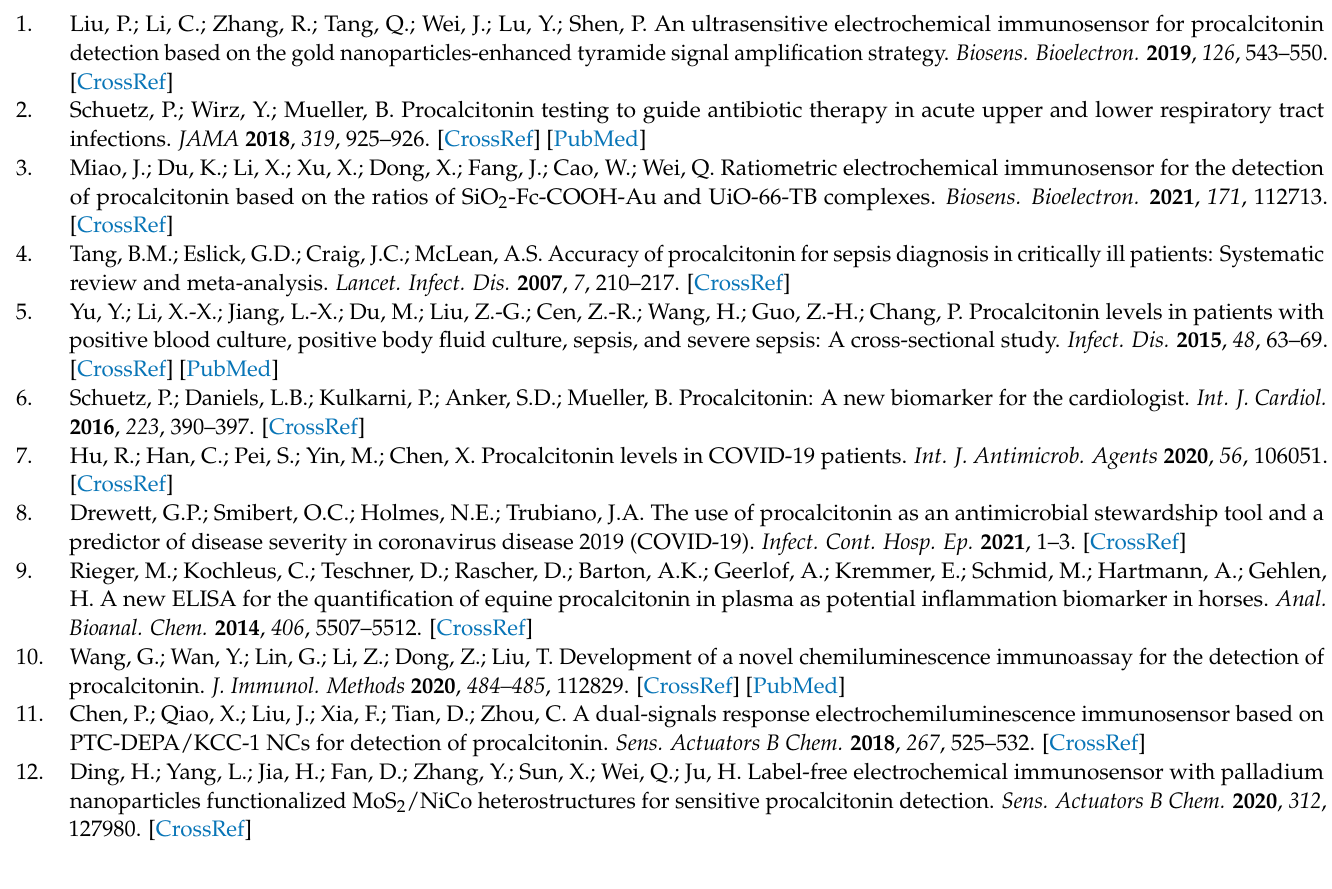
of the performance of the proposed PEC immunosensor for PCT detection and those of other reports; Table S2: The results of the PCT determination in human serum